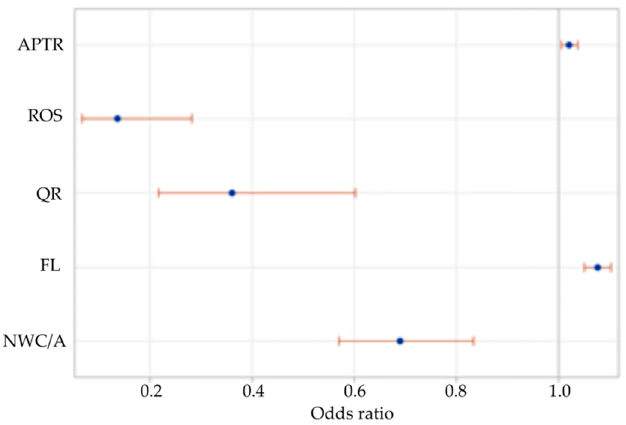
Figure 2. Odds ratios with 95% Wald confidence limits.